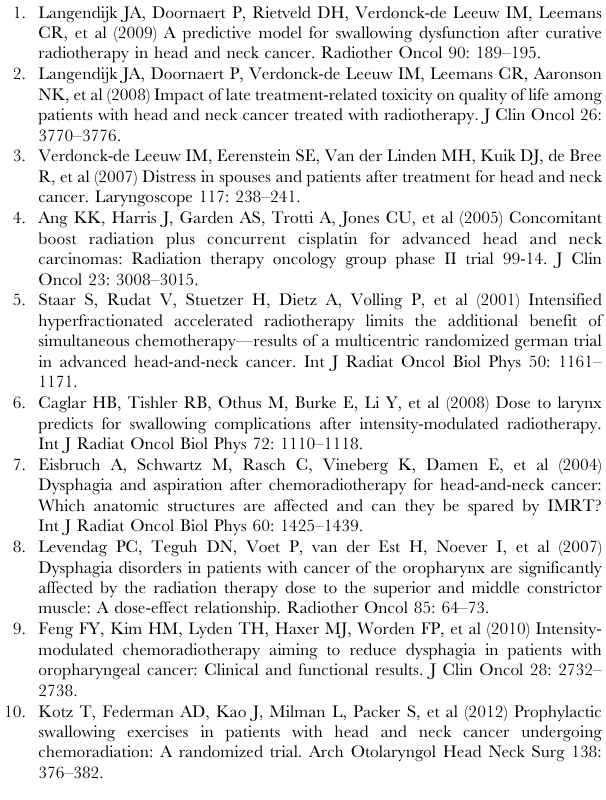
Table S1 Performance of the prediction model for TUBEM6. Abbreviations: AUC, Area Under Curve; H-L, Hosmer-Leme-